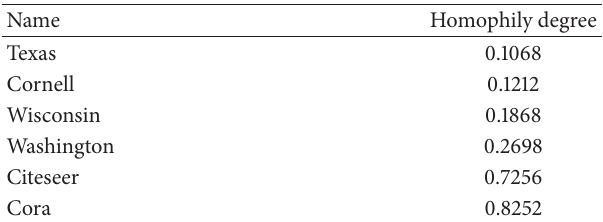
Table 2: The homophily degrees of the networks in Table